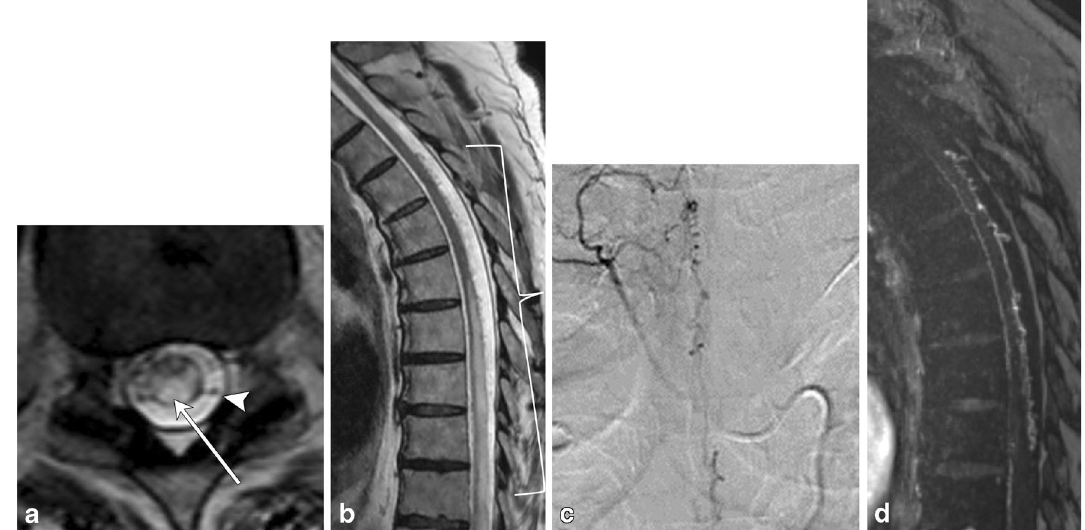
Fig. 19 Dural arteriovenous fistula. A 72-year-old male with progressive lower extremity weakness, without improvement in symptoms after lum- bar laminectomy. a Axial T2 image demonstrates numerous flow voids in the thecal sac (arrowhead). There is high signal in the cord due